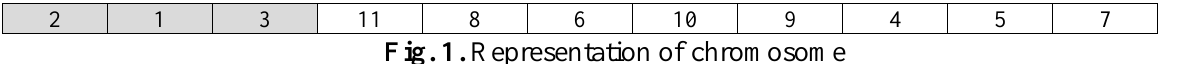
Fig. 1. Representation of